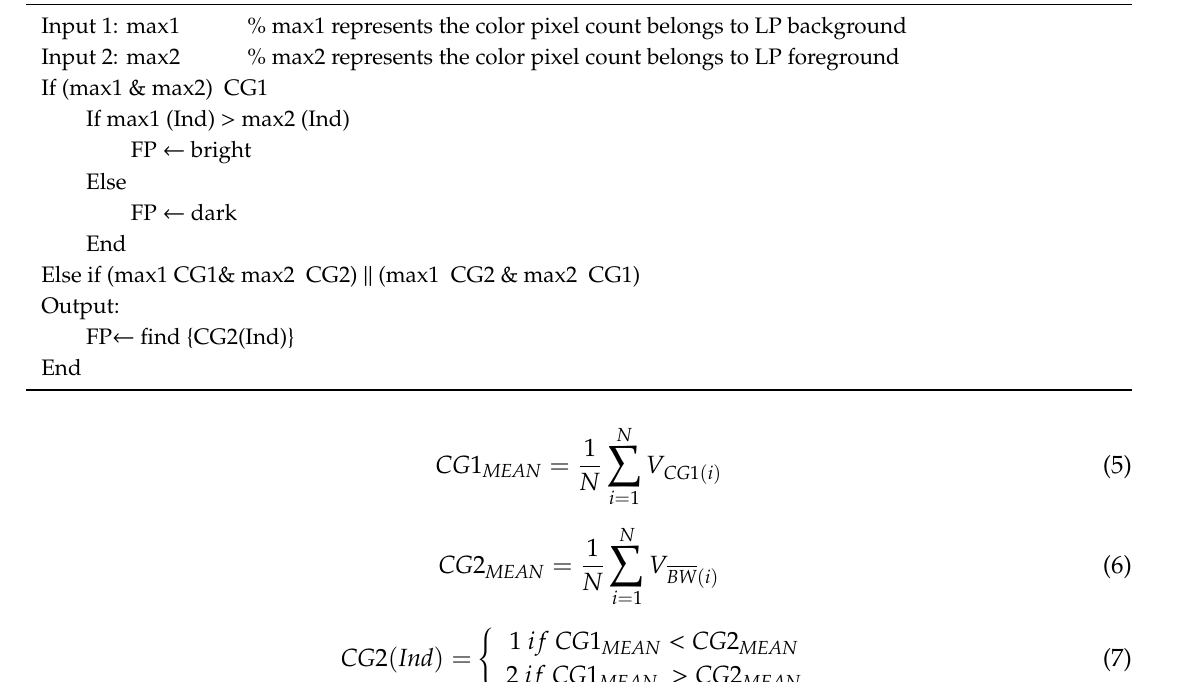
Algorithm 1 Foreground polarity detection